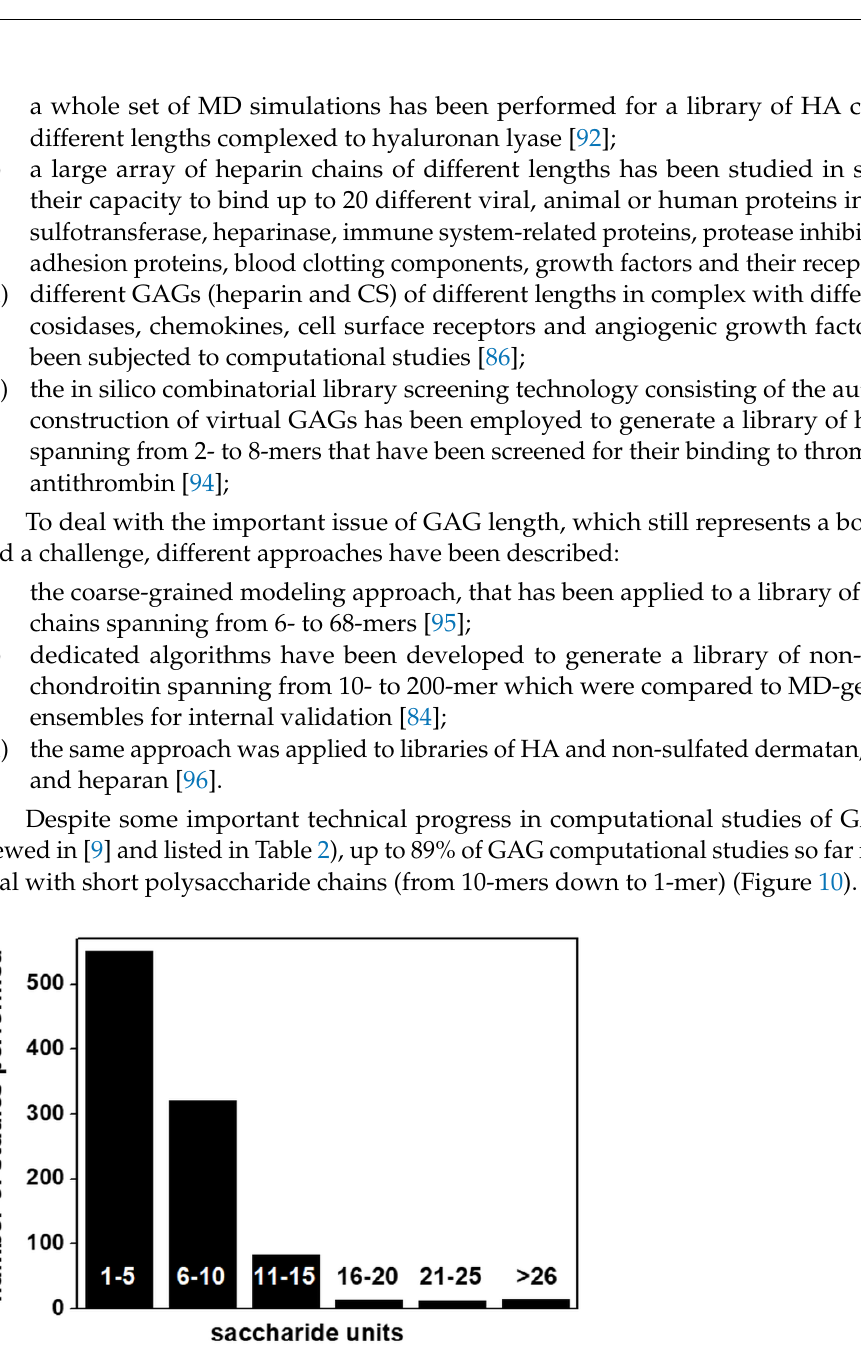
Figure 11. Distribution of computational structural studies of GAG alone and of GAGs complexed with the indicated ligand. For further details on the bibliographic research strategy, see Appendix A.